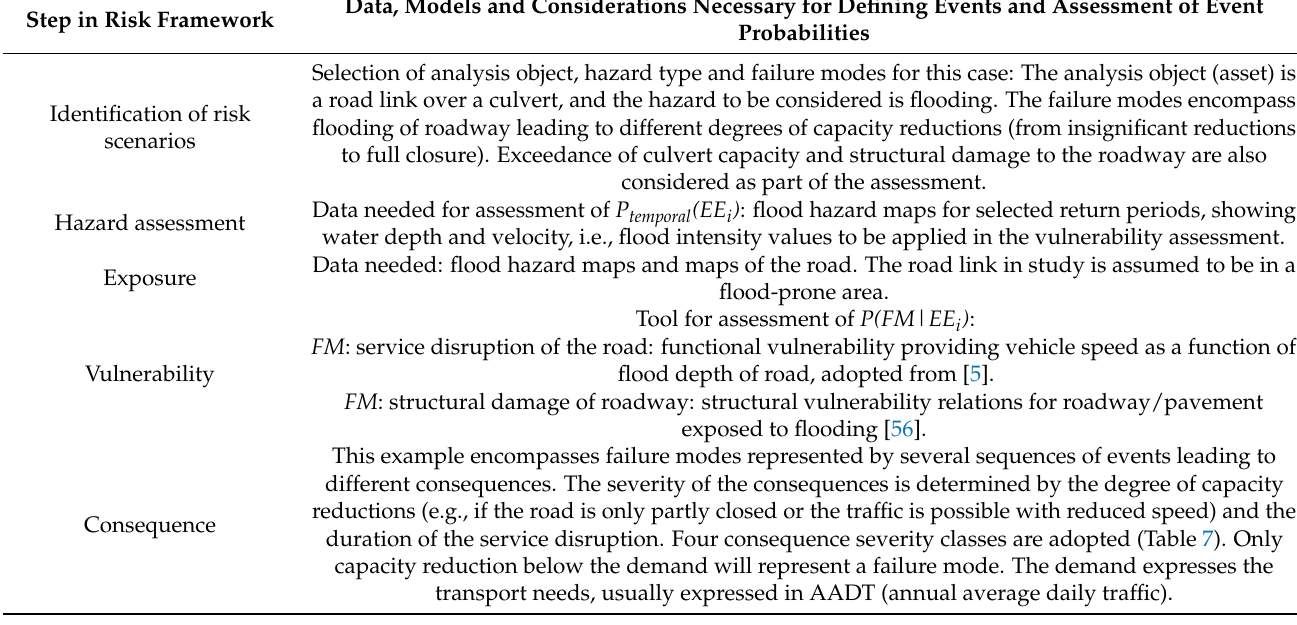
Table 6. Data and models needed for the assessment.